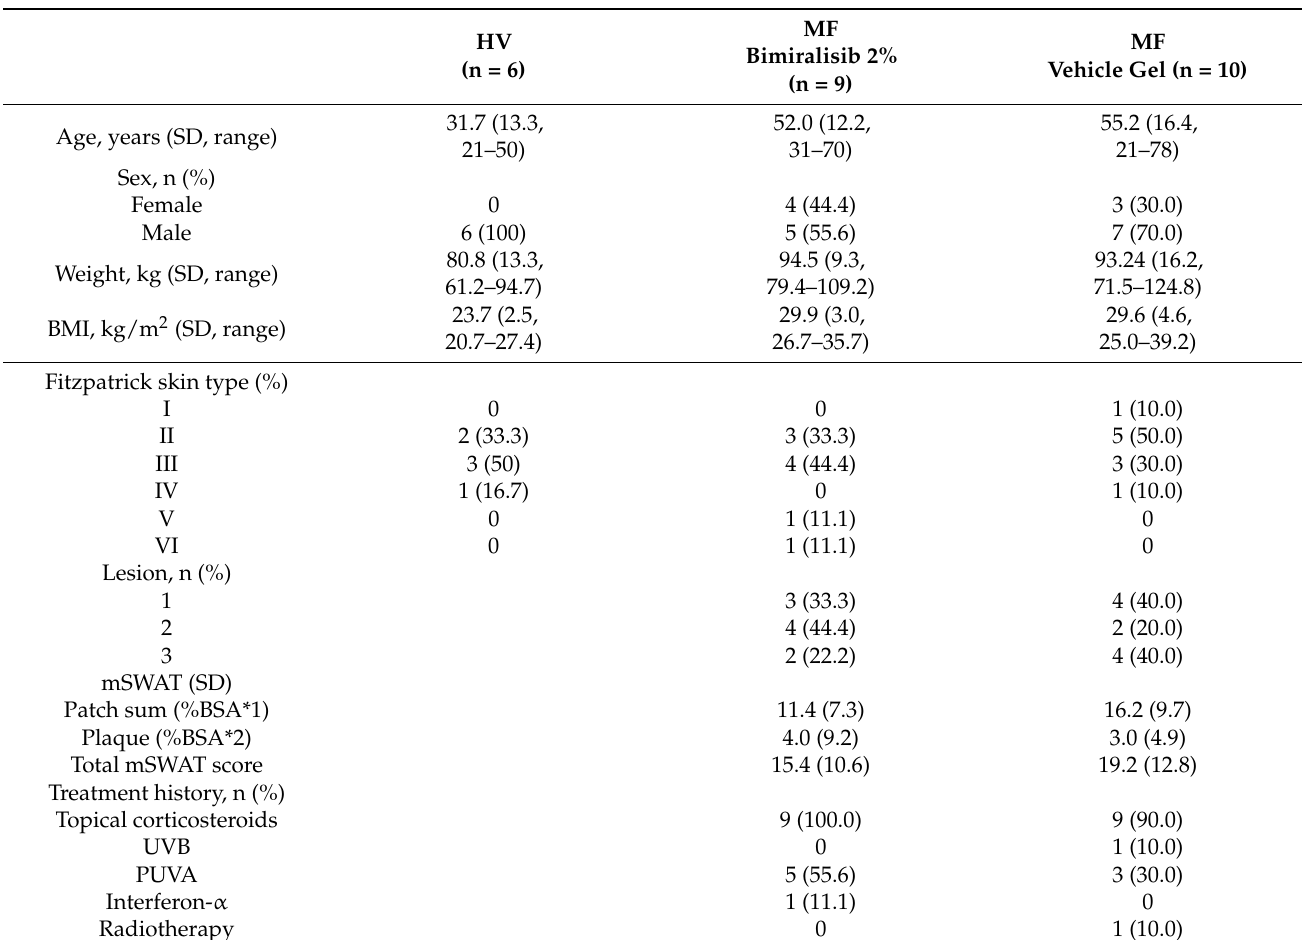
Table 2. Baseline and disease characteristics of HVs and MF